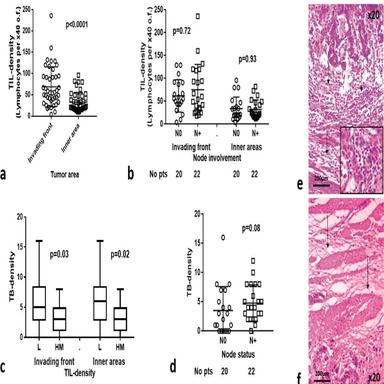
Analysis of TIL-density and histopathological variables: (a) Distribution of TIL-density in the invading tumor front and inner tumor areas; (b) Distribution of TIL-density in the invading tumor front and inner tumor areas according to node involvement; (c) Distribution of TIL-density in the invading tumor front and inner tumor areas according to the tumor budding (TB-density); (d) TB-density according to node status; (e) Typical immunohistochemical image of high TIL-density in the invading tumor front (arro